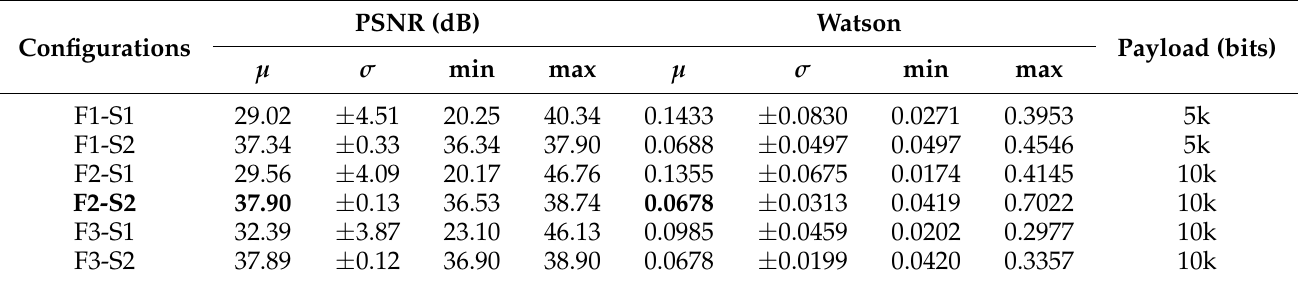
Table 3. Perceptual distortion performance for framework configuration. The best configuration in terms of average PSNR and Watson values is highlighted in